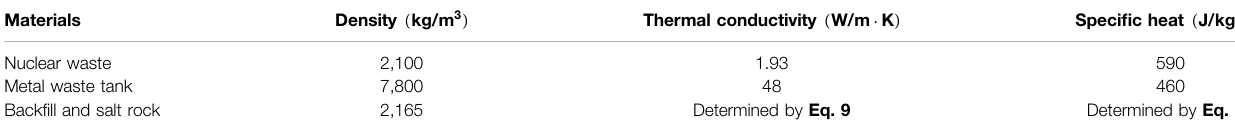
TABLE 4 | Physical and thermal parameters of materials. Materials